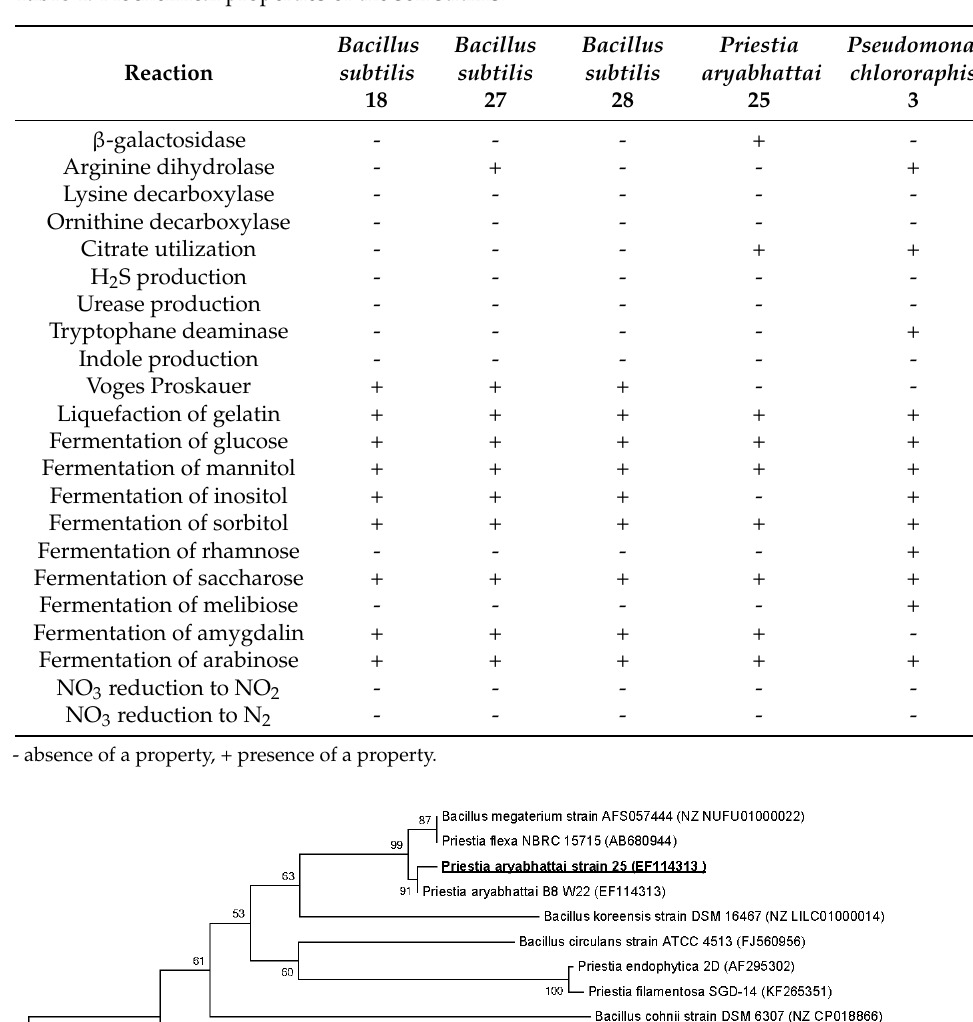
Table 4. Biochemical properties of the soil strains.